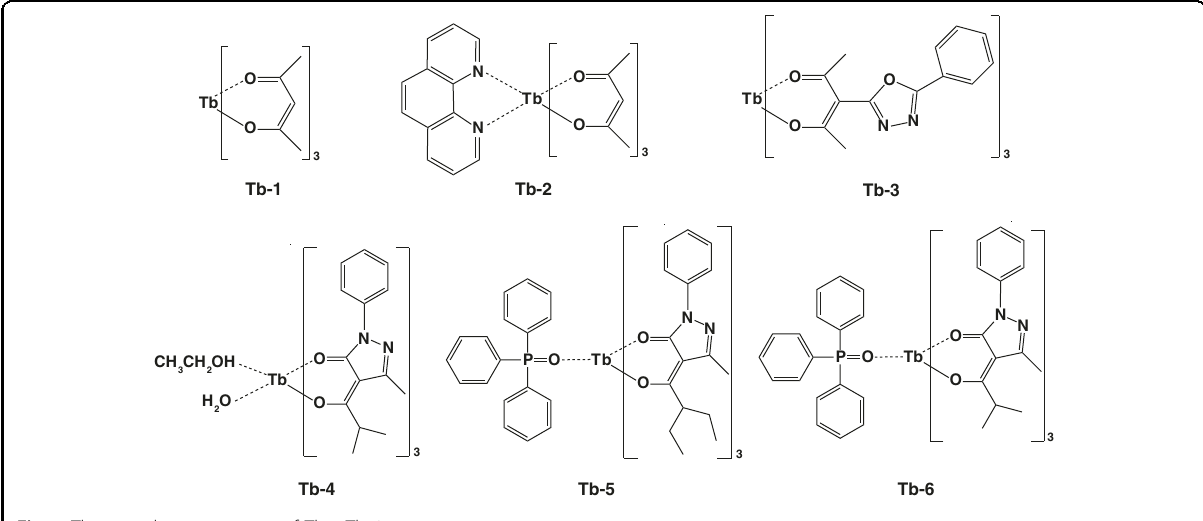
Fig. 4 The complexes structures of